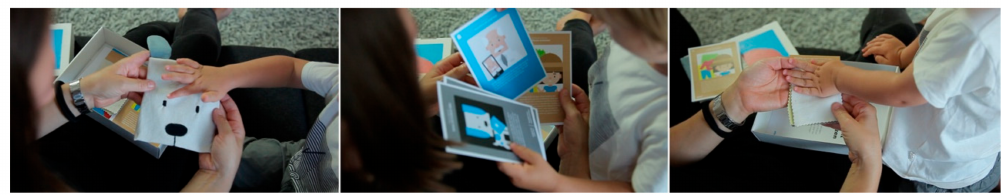
Figure A1. Atopi Box and brochure.